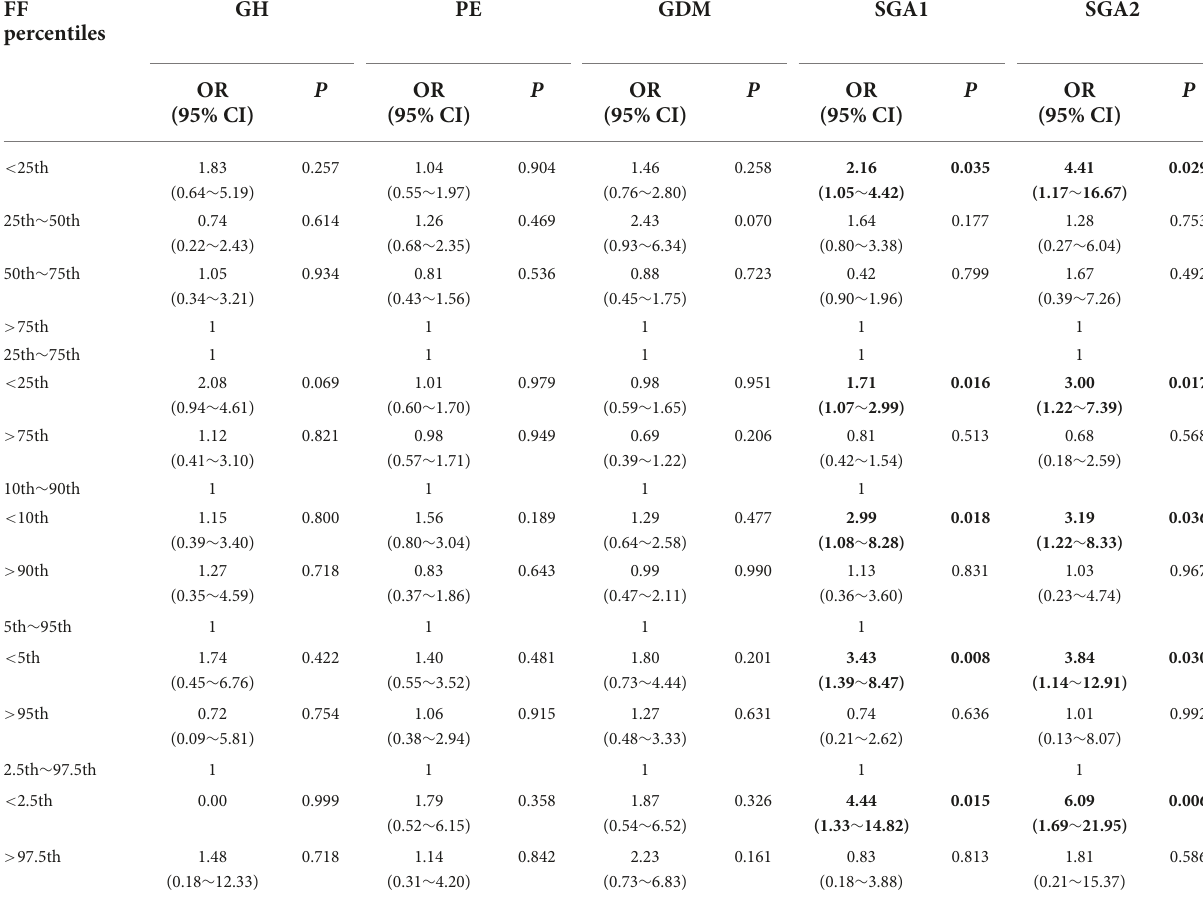
TABLE 3 Association between different FF percentiles on NIPT and pregnancy complications related to placental dysfunction in adjusted models. FF GH PE percentiles